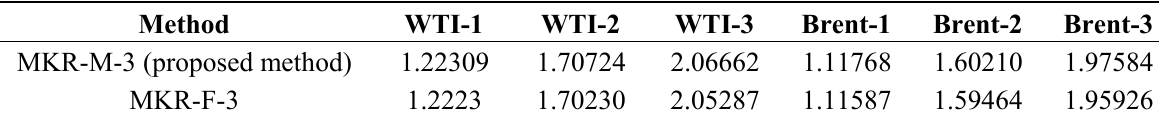
Table 11. Average RMSE results for WTI and Brent crude oil price prediction (14 experiments in total).